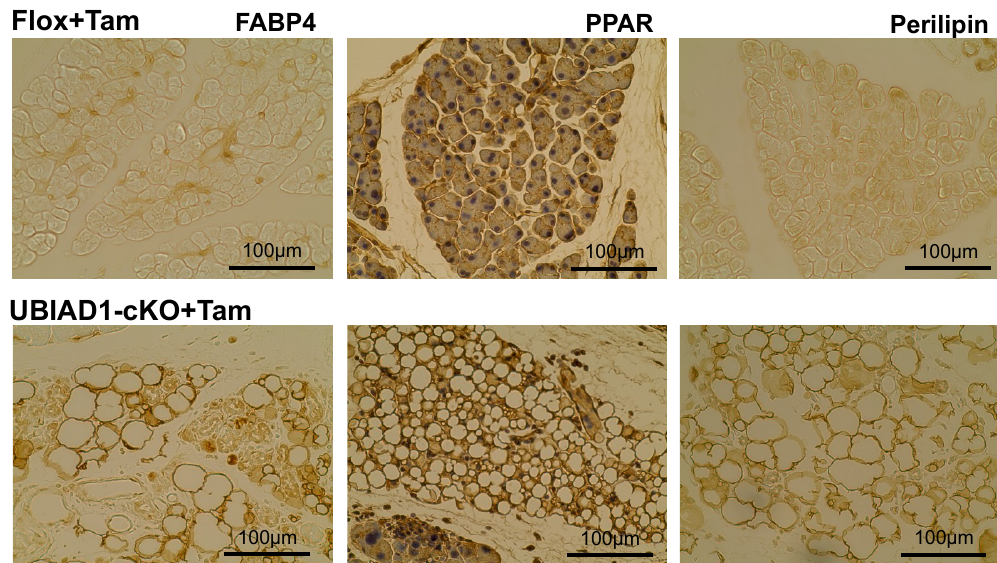
Figure 5. Expression of adipocyte-specific markers in the vacuoles in tamoxifen-treated UBIAD1-cKO mice. Immunohistological staining with FABP4, PPAR, and perilipin in the pancreas of the tamoxifen-treated Flox and UBIAD1-cKO mice at 40 days after administration of tamoxifen. The tissues of immunohistological staining with PPAR staining were counterstained with hematoxylin.